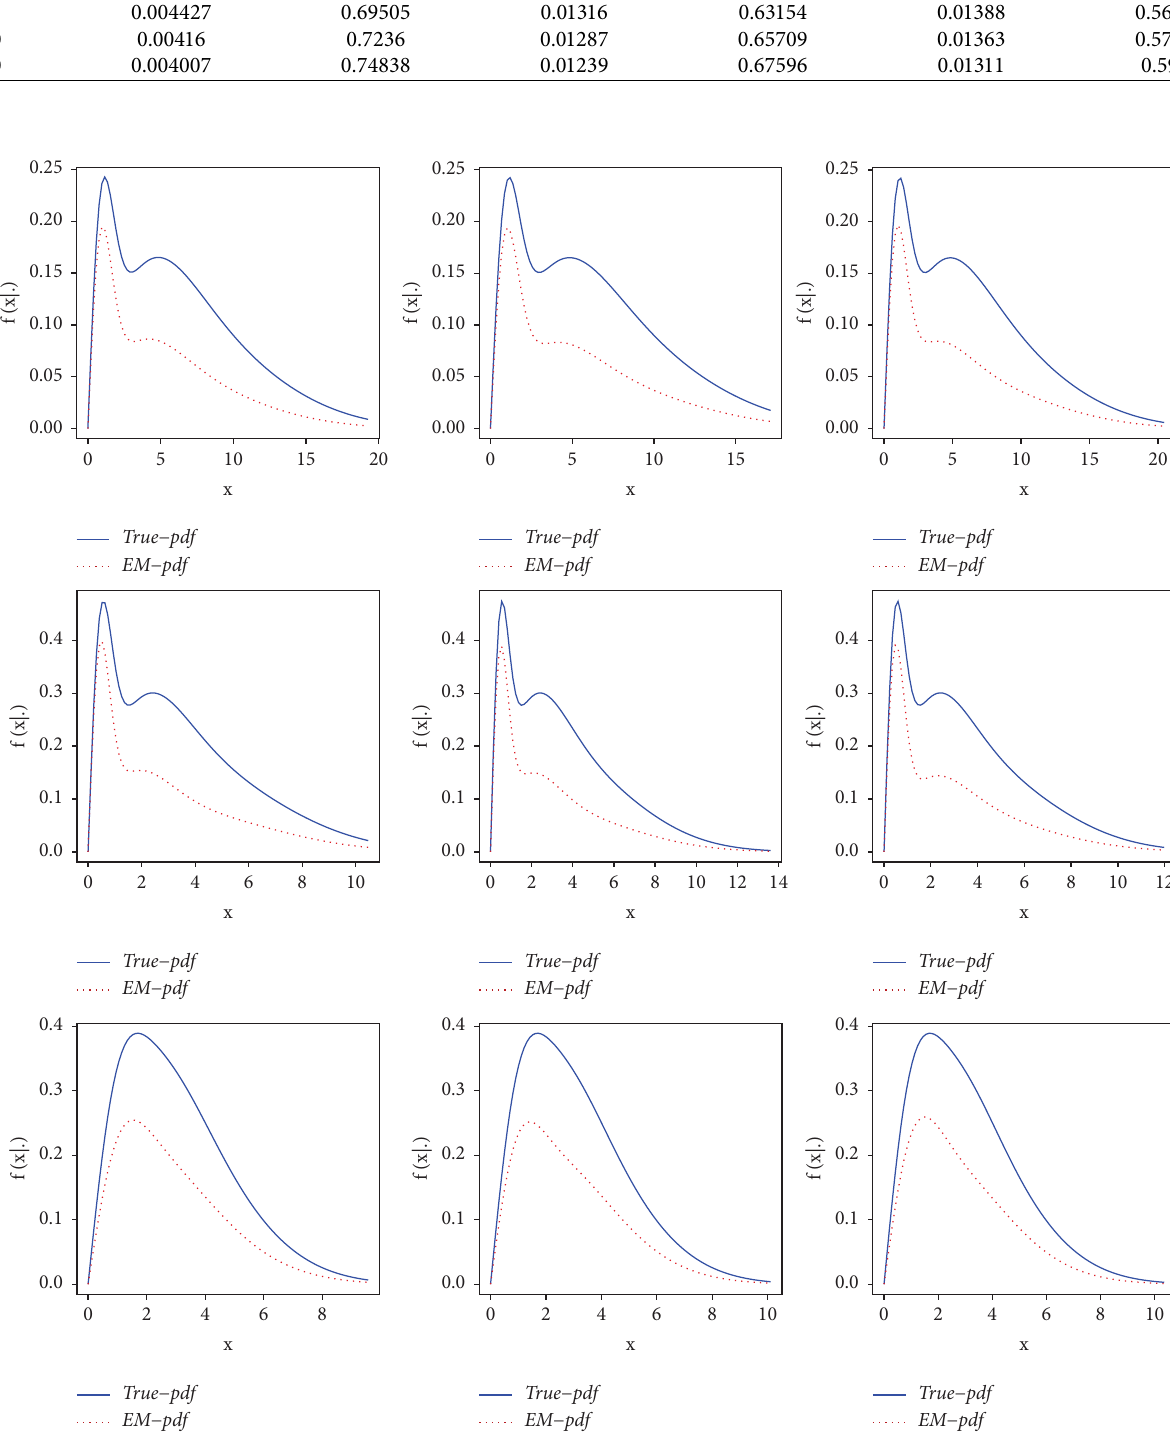
Figure 2: Te graphs of the PDF of the model for true parameters and estimated ones by the EM algorithm. Te columns of the graphs represent the sample sizes n � 90, 120, and 200, respectively. Te rows of the graphs represent the parameter scenarios ( π 1 , π 2 , θ 1 , θ 2 , θ 3 ) � (0.3, 0.3, 1, 4, 7), (0.3, 0.3, 0.5, 2, 4), and (0.2, 0.3, 1, 2, 3),